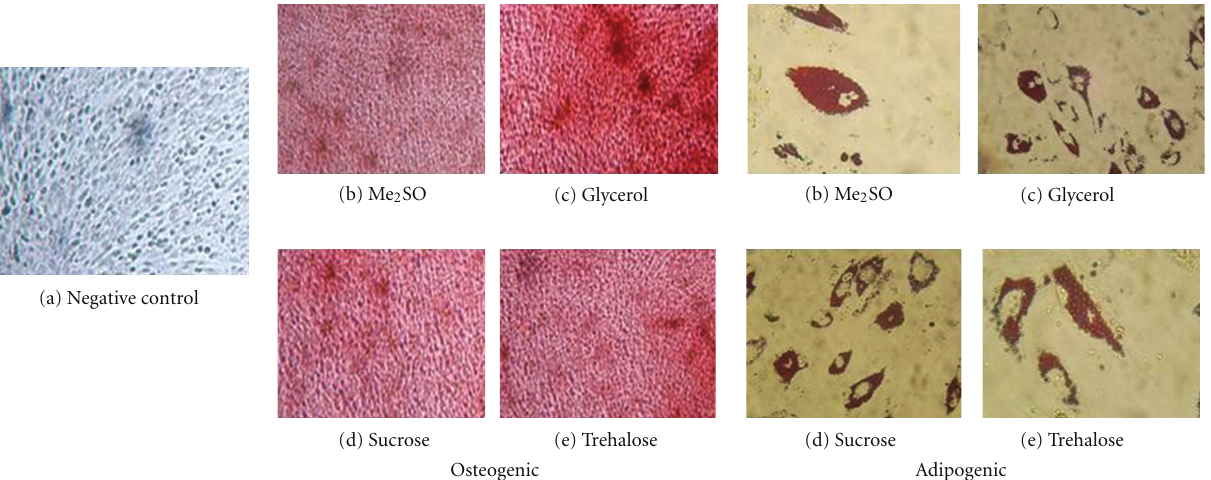
Figure 7: After thawing, AFSCs freezed with di ff erent cryoprotectants ((b) Me 2 SO, (c) glycerol, (d) sucrose, and (e) trehalose) were cultivated with osteogenic and adipogenic inductor medium. Di ff erentiation was confirmed by Alizarin Red and Oil Red O staining after 21 days. (a) Control cells without inductor. Calcium deposits appear in red. All cryoprotectants tested maintained osteogenic and adipogenic di ff erentiation potential of AFSCs after storage for 6